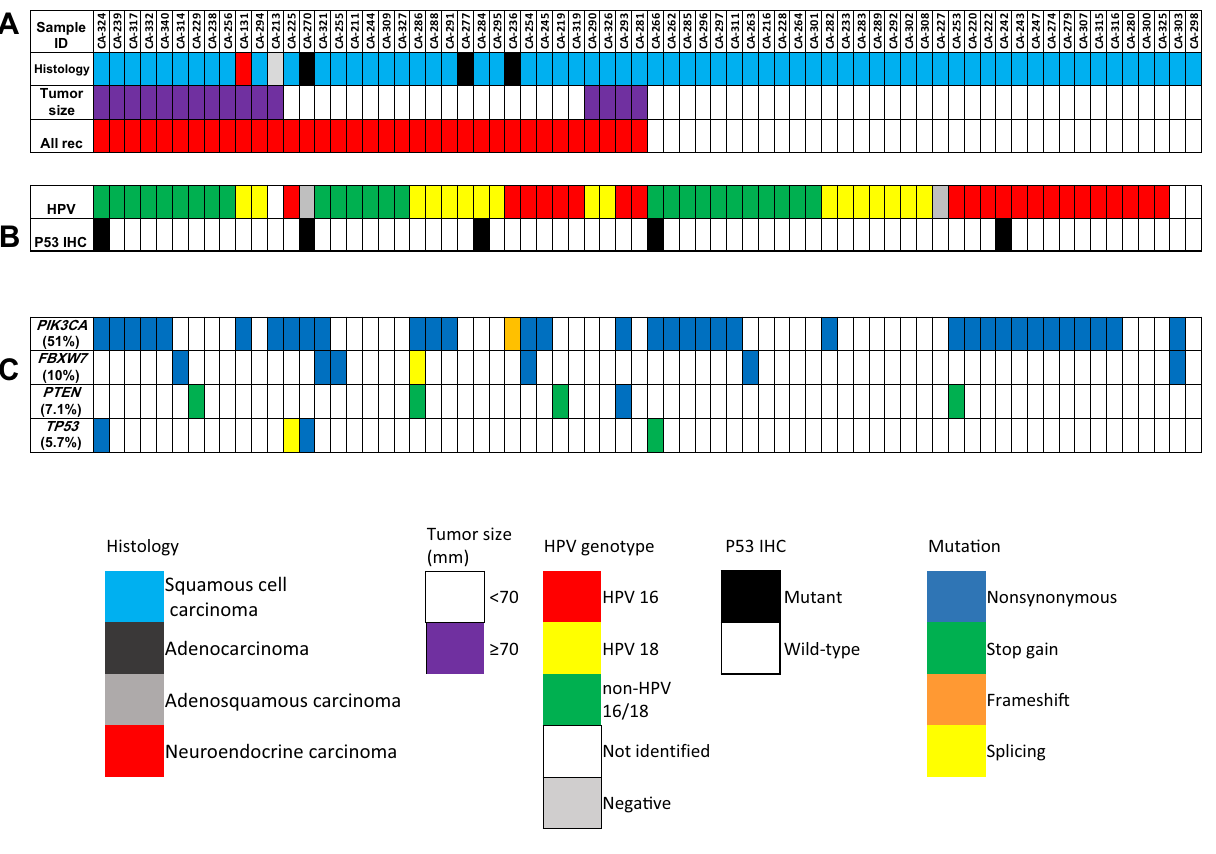
Figure 1. Clinicopathological factors and mutation profile (more than 5% frequency) in our cohort. ( A ) Clinical factors, histological types, and recurrence status; ( B ) HPV genotype and IHC staining pattern; and ( C ) mutation profile of the seventy patients with cervical cancer. Mutated genes are color-coded according to their mutation type. Data analysis was carried out using the Torrent Suite Software v5.0.4 (Thermo Fisher